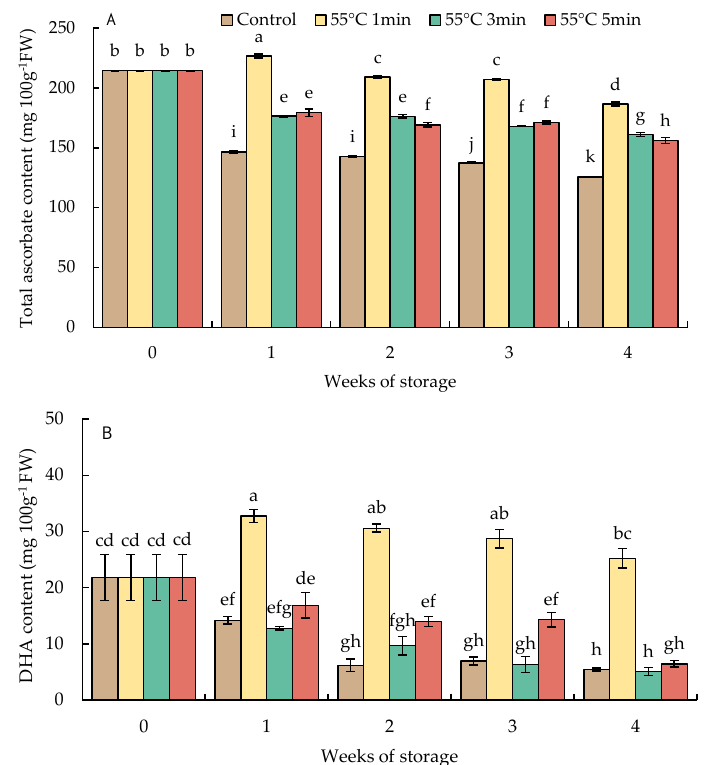
Figure 8. Effect of hot water treatment (55 ◦ C for 1, 3, 5 min) on ( A ) total ascorbate and ( B ) de- hydroascorbate (DHA) contents in red sweet pepper fruit during storage at 10 ◦ C. Data represent means ± S.E. (n = 3). Different letters on bars are significantly different ( p < 0.05).